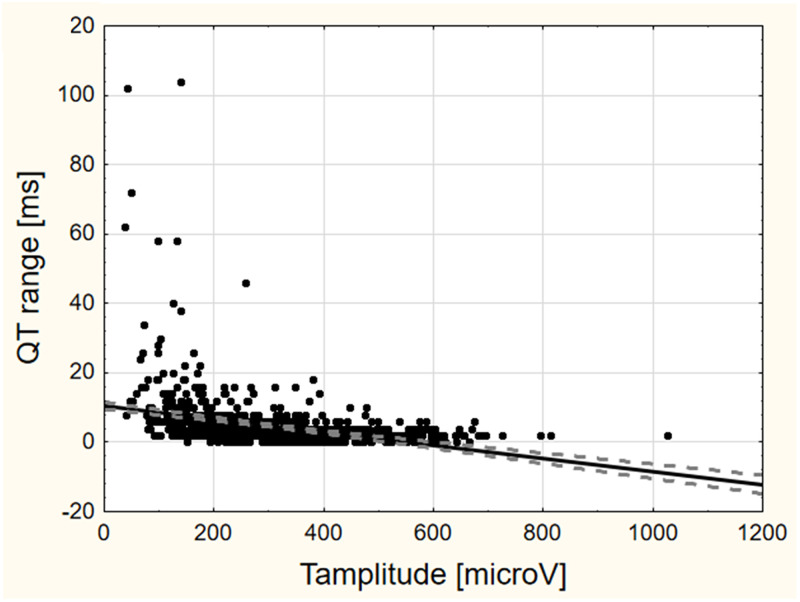
The lower the T wave amplitude the greater the QT range.This graph shows the inverse relation between the ranges in QT (maximum-minimum value) in the selected 50s-segment and the T-wave amplitude. The lower this amplitude the greater the differences in Tend and therefore also in the QT interval (rs = -0.48; p < 0.001; rs2 = 0.23). rs is the Spearman rank order correlation coefficient.